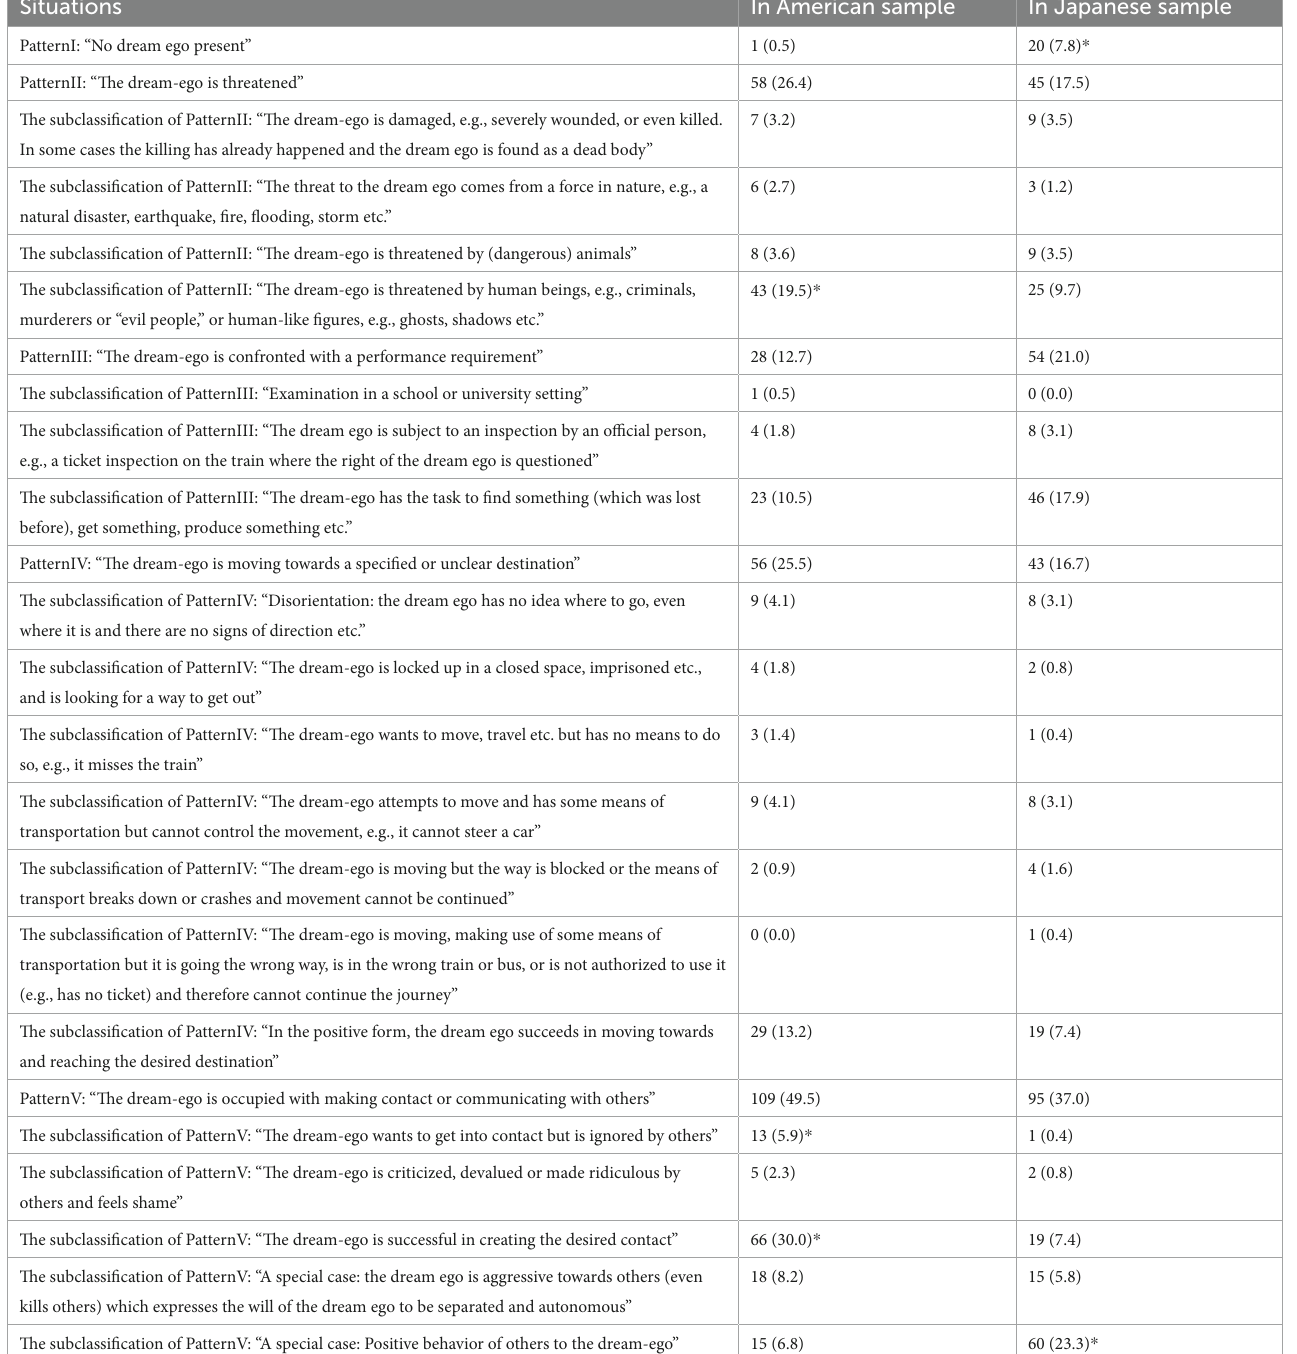
TABLE 6 The rate of incidence of each general structural pattern in the American and Japanese samples for “recent impressive dreams”. Situations In American sample In Japanese